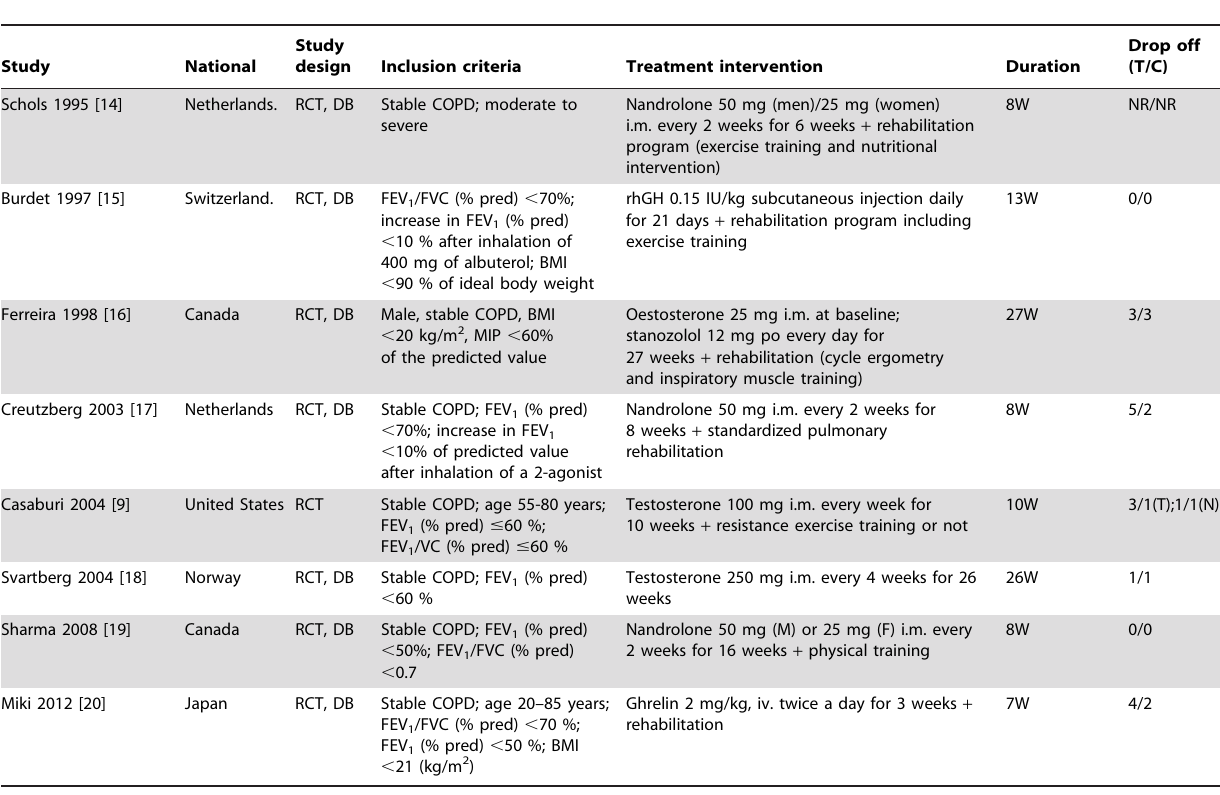
Table 1. Characteristics of studies included in this